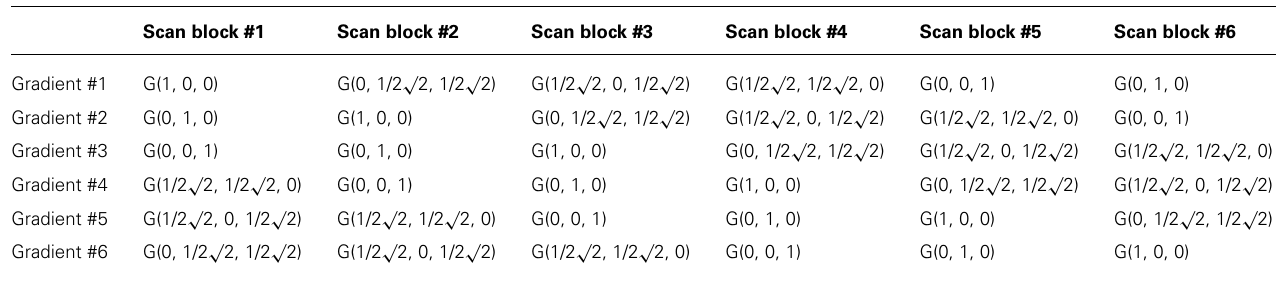
Table 1 | Gradients settings used in the visual and tactile fDTI